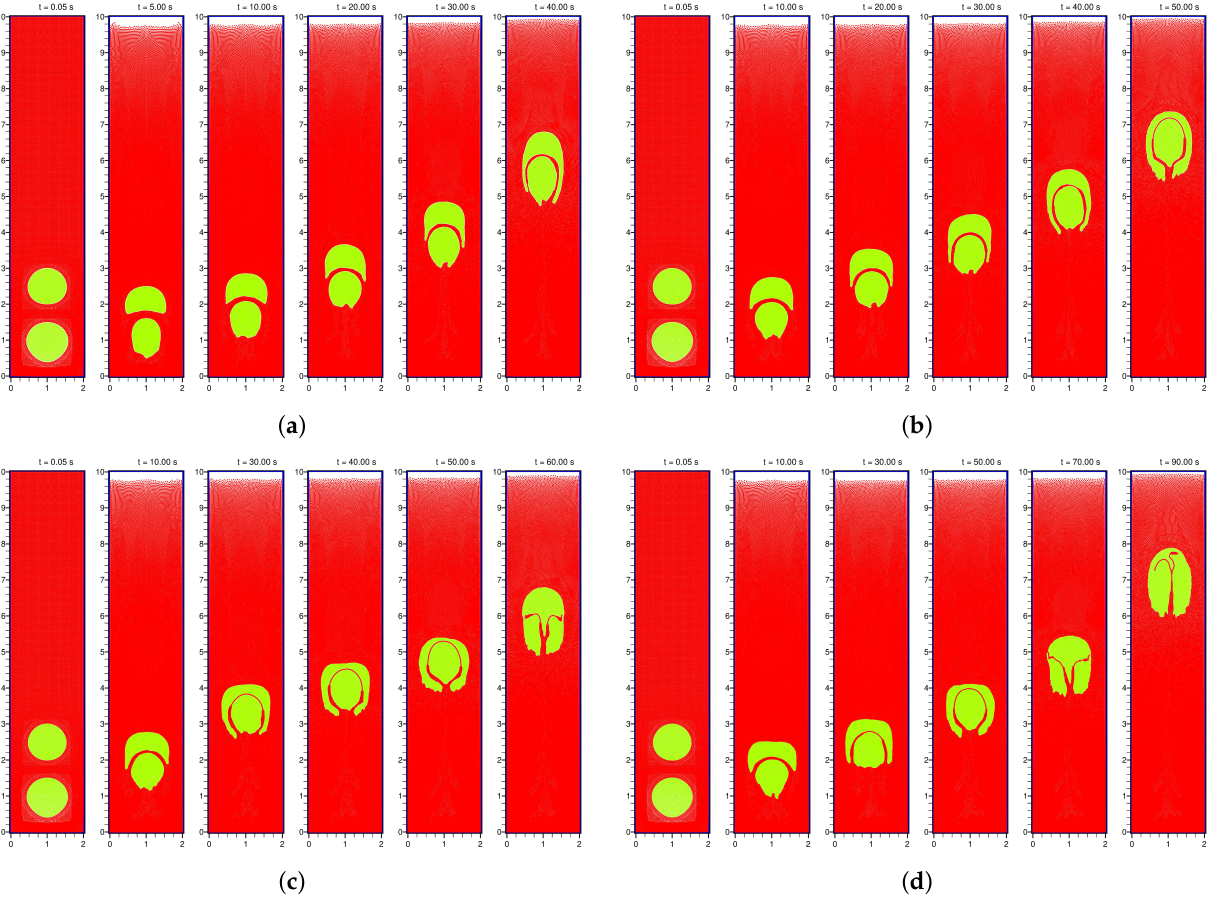
Figure 11. The evolution of a pair of rising bubbles with density ratio ρ g and 0.44 ( d ),